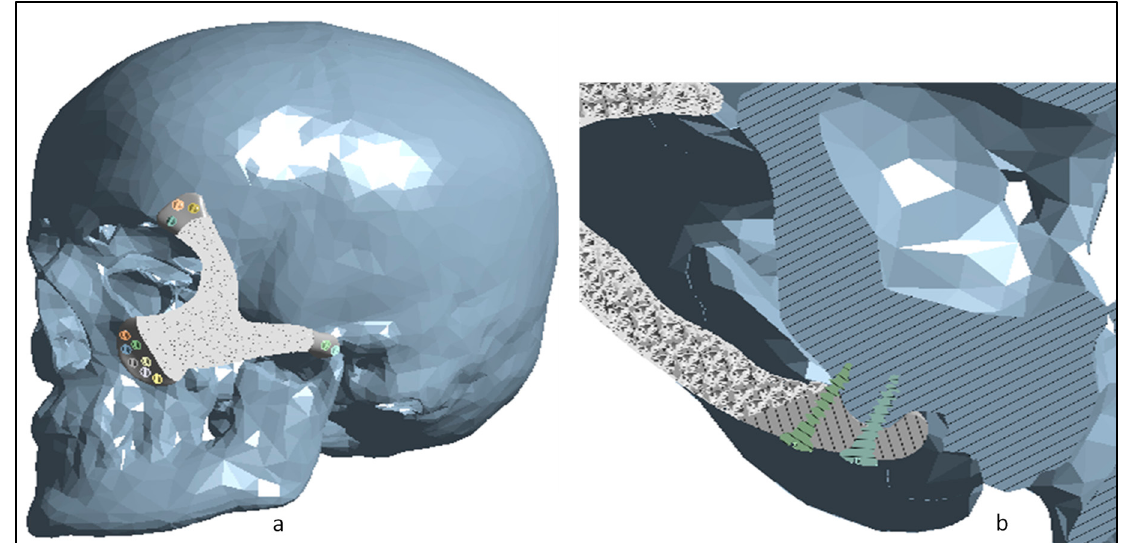
Figure 9. ( a ) The 3D FEM consisting of the skull, craniofacial implant and the fixation screws, and ( b ) cross-section view of the screw insertion into the implant–bone region.